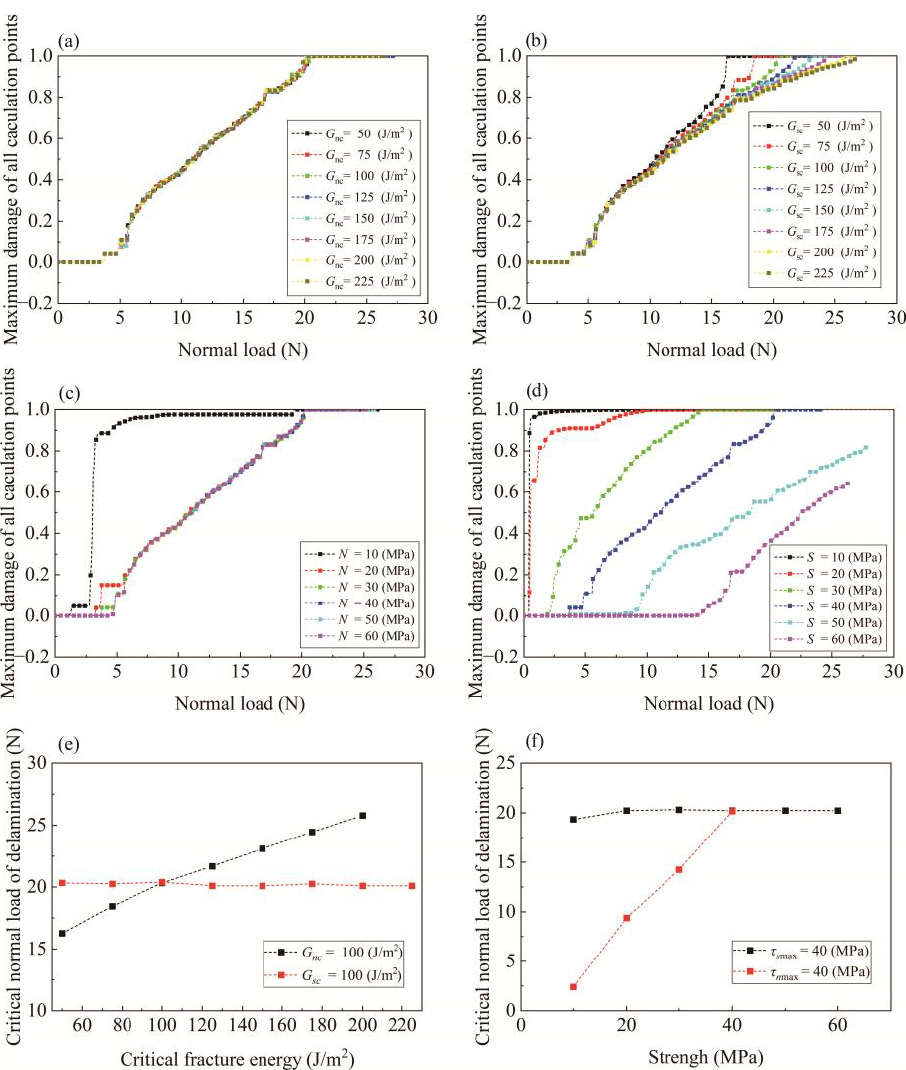
Figure 11. Effect of ( a ) G sc ,( b ) G nc , ( c ) S and ( d ) N on delamination process; Effect of ( e ) fracture energy and ( f ) strength on critical load of delamination.